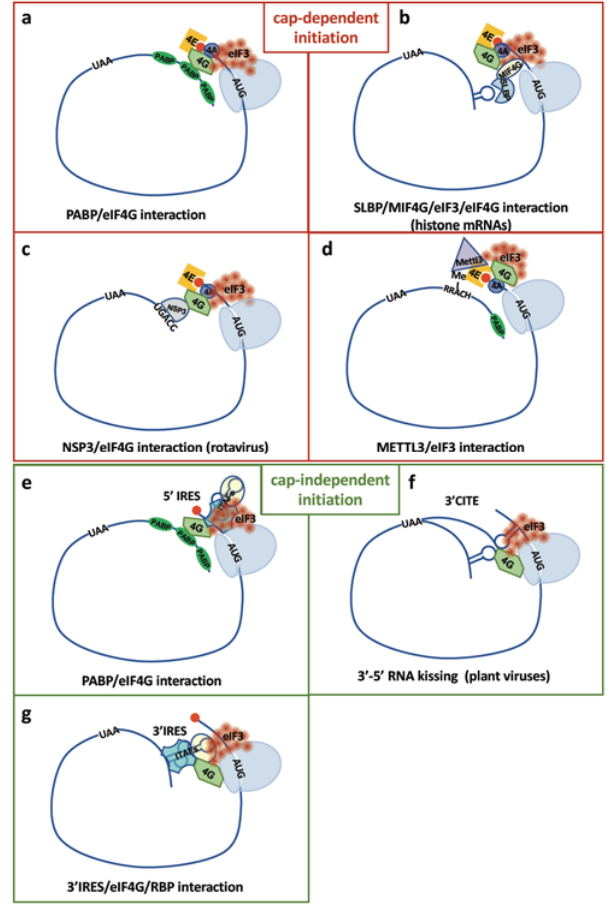
Figure 2. mRNA functional circularization is mediated by different mechanisms. Several mechanisms of mRNA circularization are represented, with the known proteins and RNA elements involved in the 3 ′ –5 ′ interaction, allowing cap-dependent ( a – d ) and cap-independent ( e – g ) translation. Each mechanism is detailed in the text (Sections 7 and 8). This list is not exhaustive and the mechanism d (METTL3/eIF3 interaction) may also serve cap-independent translation.